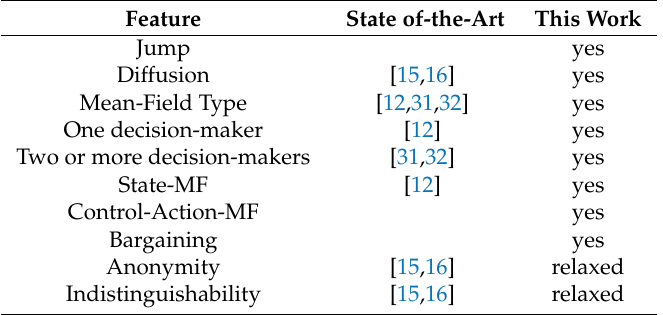
Table 1. Some recent developments on mean-field-type linear–quadratic–Gaussian (MF-LQG)-related